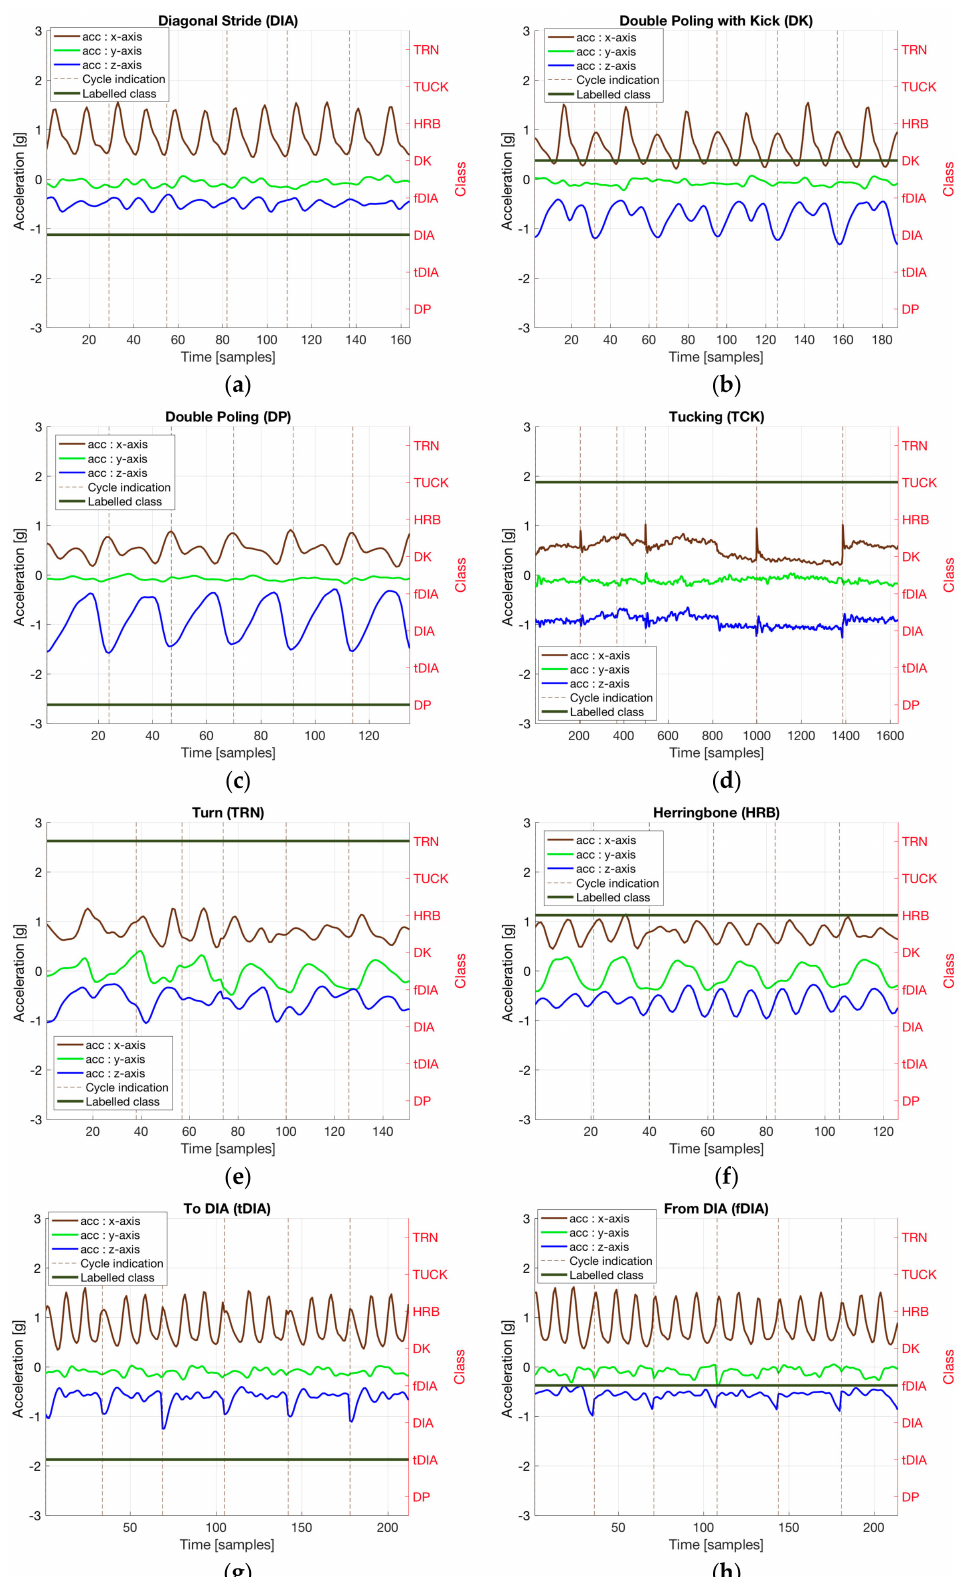
Figure 3. Six cycles of each sub-technique class definition are plotted in ( a ) for DIA, ( b ) for DK, ( c ) for DP, ( d ) for TCK, ( e ) for TRN, ( f ) for HBN, ( g ) for tDIA, and ( h ) for